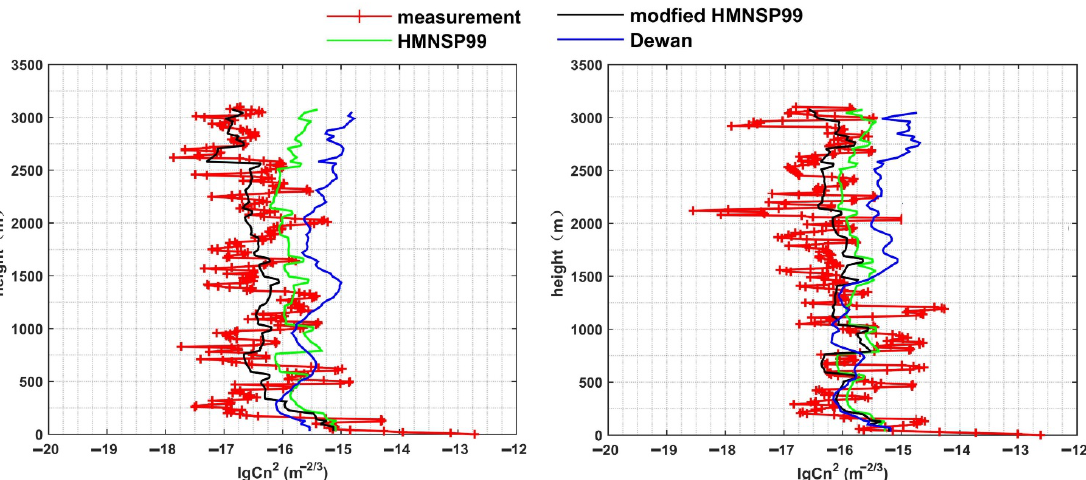
Figure 7. Comparison of the C 2 n profiles between measurements conducted by the meteorological balloons and calculations by different outer scale models including HMNSP99, the modified HMNSP99, and